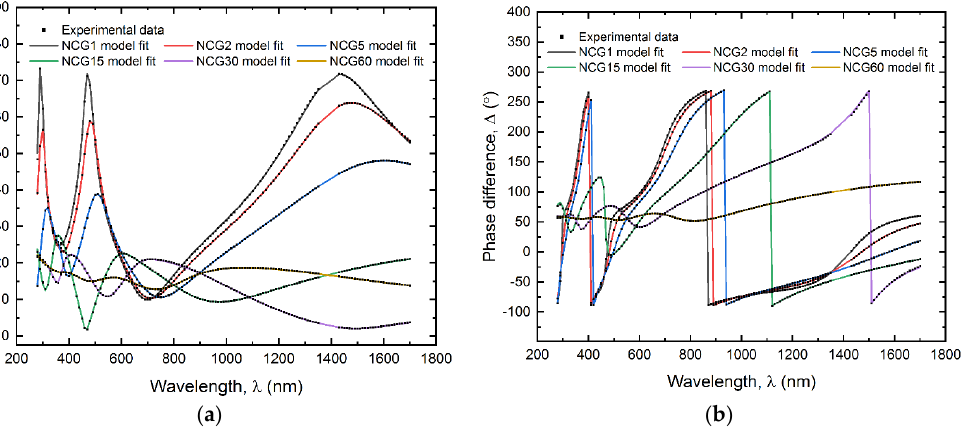
Figure 2. Comparison of the measured and calculated ( a ) amplitude ratio and ( b ) phase difference spectra, at a 70 ◦ angle of incidence, of the thin NCG films grown at different time